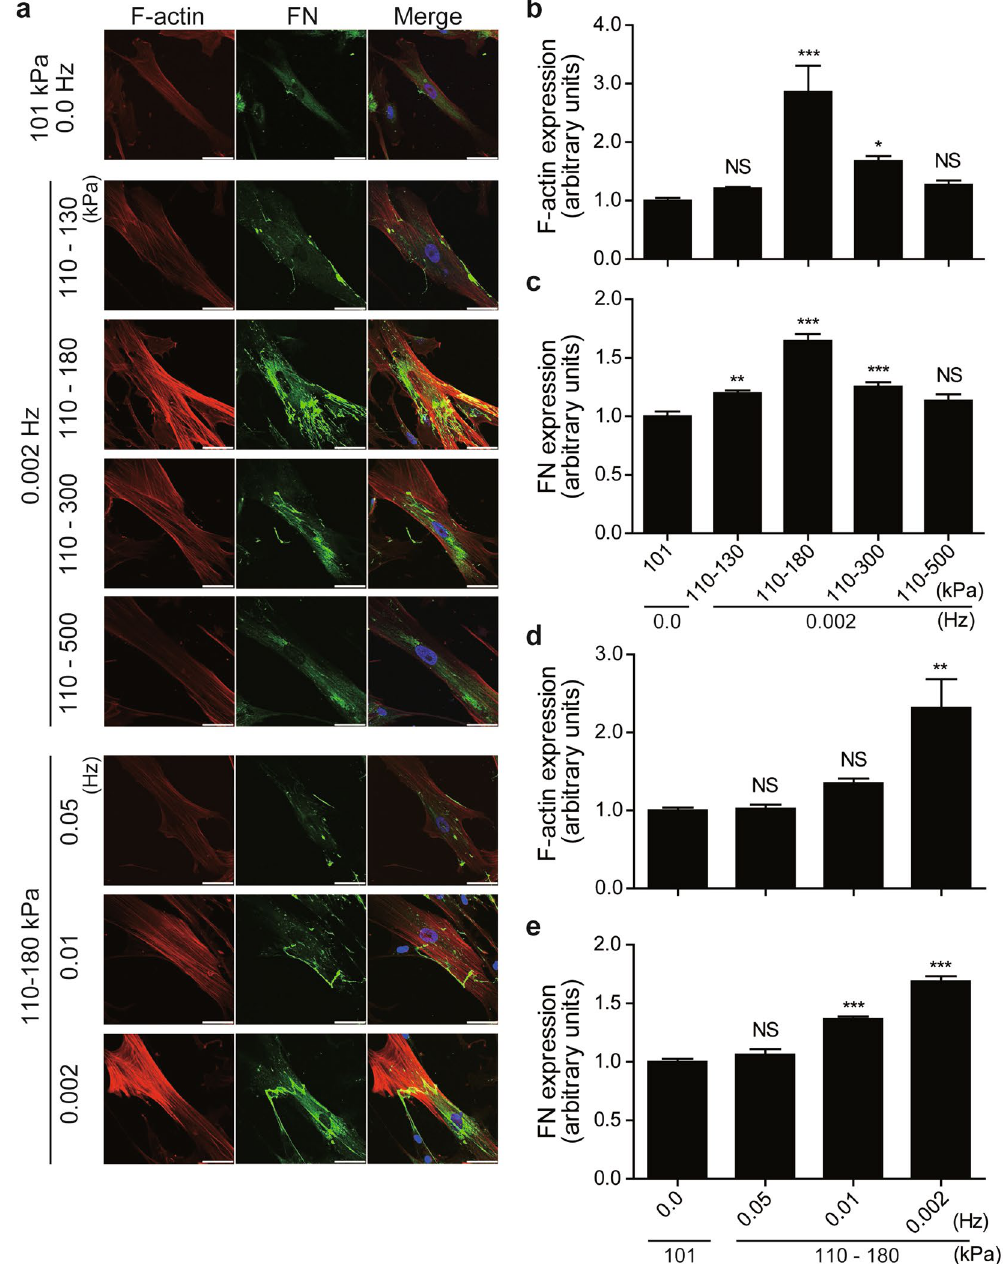
Figure 1. The effects of periodic hydrostatic pressurization (PHP) on stress-fiber formation and fibronectin (FN) fibrillogenesis. ( a ) Representative images of immunocytochemistry of hUASMCs exposed to various patterns of PHP for 24 h. Cells were stained for F-actin and FN to visualize stress-fiber formation and FN fibrillogenesis. Scale bars: 50 μ m. ( b and c ) Quantification of intensity of F-actin and FN of the cells exposed to pressure from 130 kPa to 500 kPa in which lower pressure was kept at 110 kPa and frequency was maintained at 0.002 Hz. ( d and e ) Quantification of intensity of F-actin and FN of the cells exposed to pressure from 0.05 Hz to 0.002 Hz in which lower and higher pressure was kept at 110 kPa and 180 kPa, respectively. n = 9–16, NS, not significant vs. 101 kPa, 0.0 Hz (atmospheric pressure); * p < 0.05; ** p < 0.01; *** p < 0.001. Values are shown as the mean ± standard error of the mean (SEM) of independent experiments. Data were analyzed using analysis of variance (ANOVA) followed by Dunnett’s multiple comparison